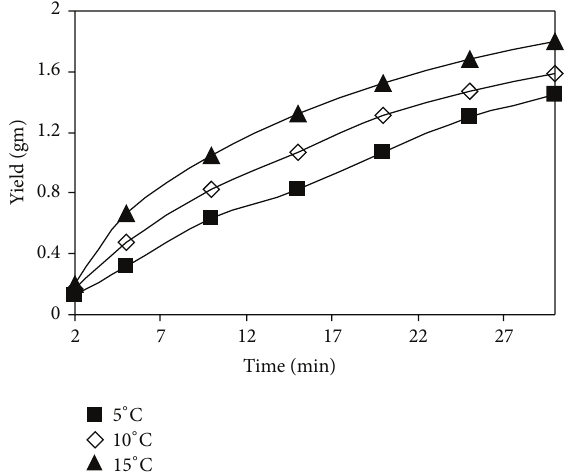
Figure 7: Yield-time curve for the effect of temperature on the aqueous oxidative polymerization of POPDA.